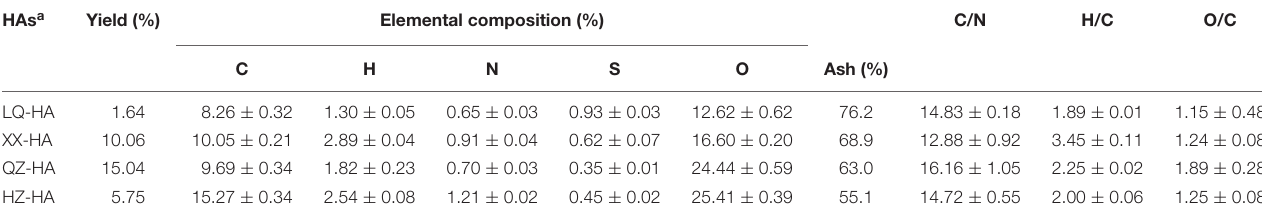
TABLE 1 | The physicochemical properties of HA